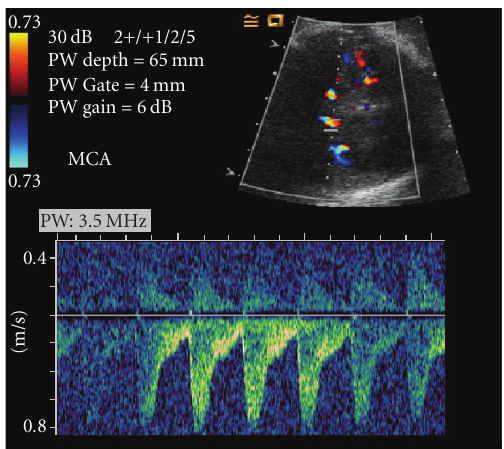
Figure 1: Doppler peak systolic velocity in the fetal middle cerebral artery showing severe fetal